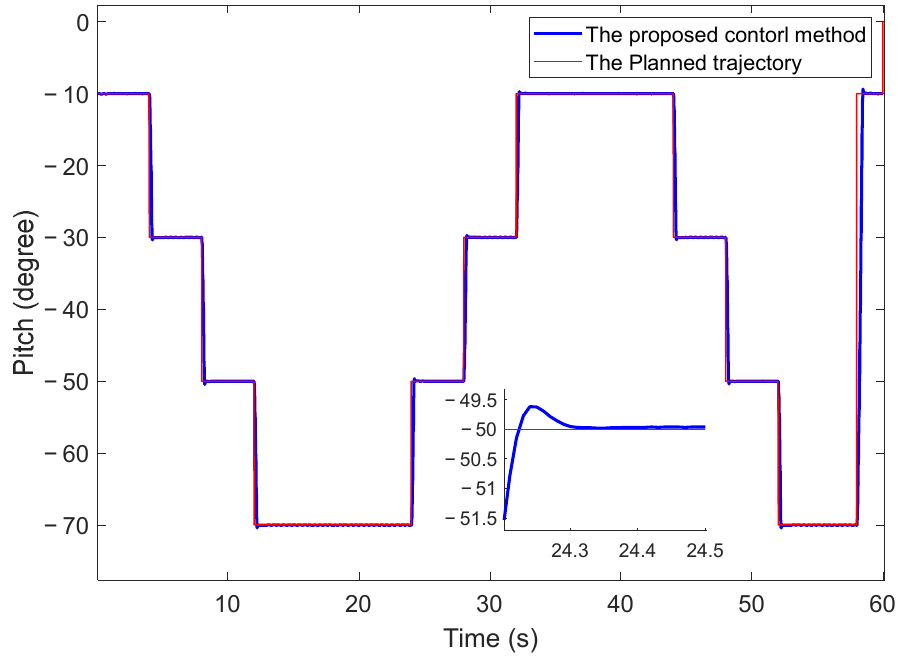
Figure 12. The flight trajectories of pitch gimbal in inspection test. The intelligent inspection system finished 35 high-voltage line wire-inspection tasks. A total of 378 faults were located in the inspection process. The located faults of the spontaneous explosion of glass insulator string are shown in Figure